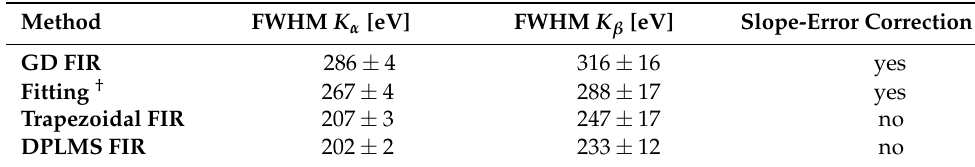
Table 3. Comparison of energy resolutions with different methods to estimate the energy